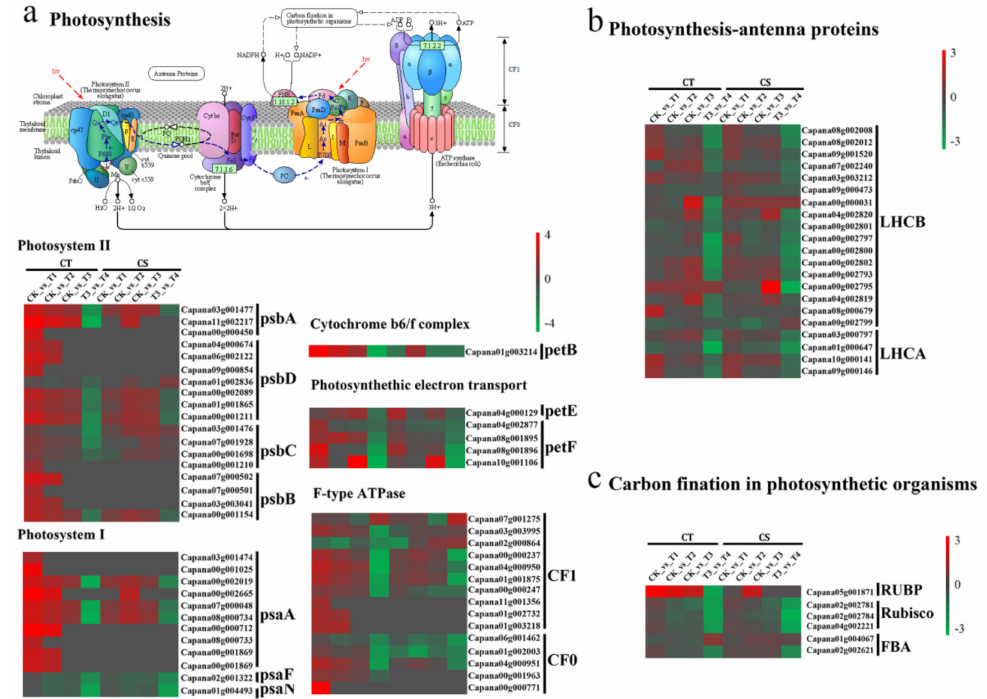
Figure 4. DEGs involved in photosynthesis, photosynthesis − antenna proteins, and carbon fix- ation in photosynthetic organisms pathways. ( a ) DEGs shared in photosynthesis and compari- son of their expression patterns in CT and CS. ( b ) Comparison of DEGs expression patterns in photosynthesis − antenna proteins. ( c ) Comparison of DEGs expression patterns in carbon fixation in photosynthetic organisms. The log2FC values were used for mapping. Red color represents high gene expressions; green color represents low gene